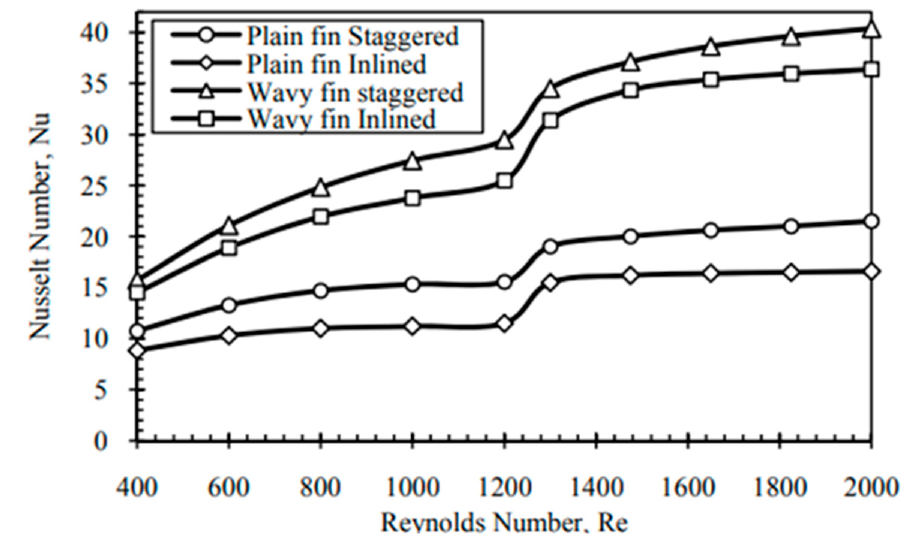
Figure 12. Nusselt number vs. Reynolds number for various fin configurations [65].